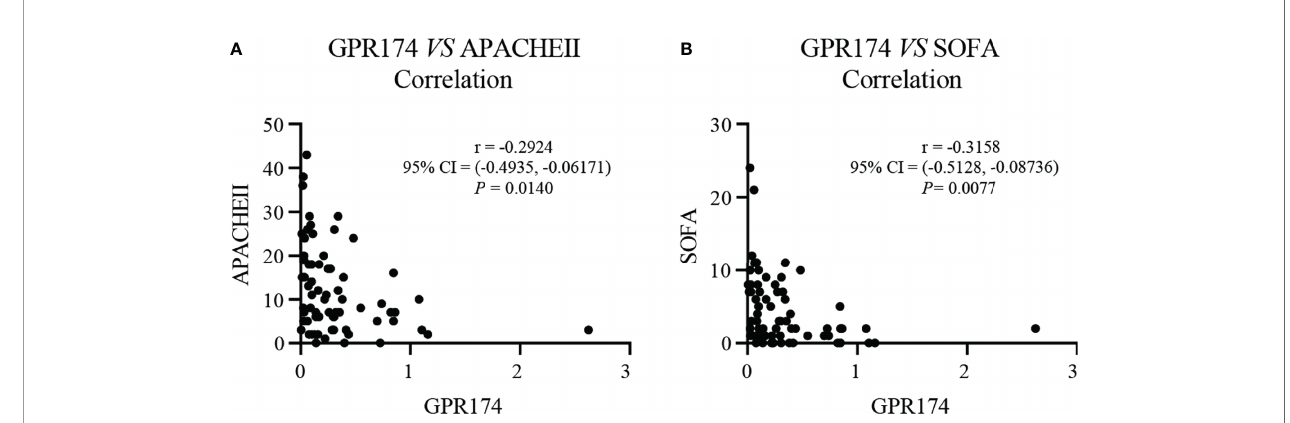
FIGURE 2 | The levels of GPR174 mRNA were correlated with disease severity in septic patients. (A) Correlation of the relative expression of GPR174 mRNA with APACHE II score in patients with sepsis. (B) Correlation of the expression of GPR174 mRNA with SOFA score in patients with sepsis. Dots represent individual participants. P values less than 0.05 were considered statistically signi fi